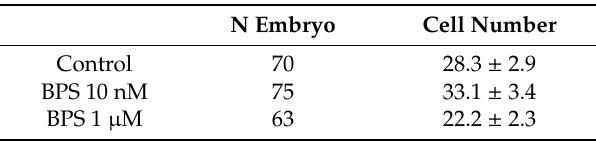
Table 2. Day 6 embryo cell number.